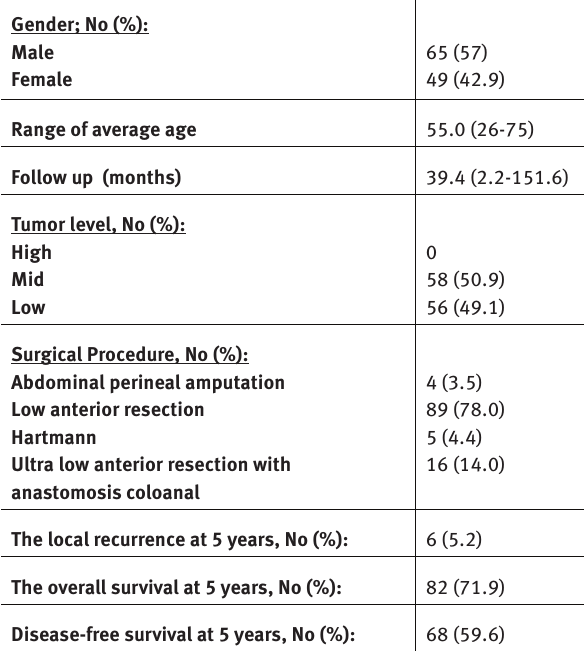
Table 1: Demographic, clinical and surgical procedures in